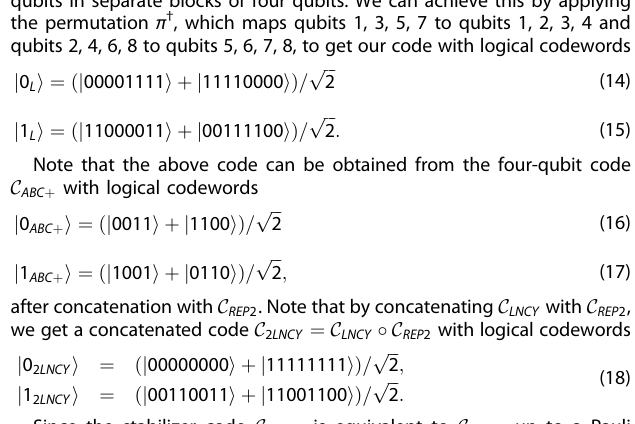
Fig. 5 Failure probability of using C 8 qubit and an unprotected qubit versus the number of timesteps when exposed to AD errors. The baseline error probability is ϵ base and the logical error probability is ϵ . At each timestep, A δ af fl icts each qubit with δ = 10 − 4 . When the target failure probability is 0.01, using C 8 qubit increases the number of timesteps T from about 100 to 200. When the target failure probability is over 0.0424, there is no advantage in using C 8 qubit